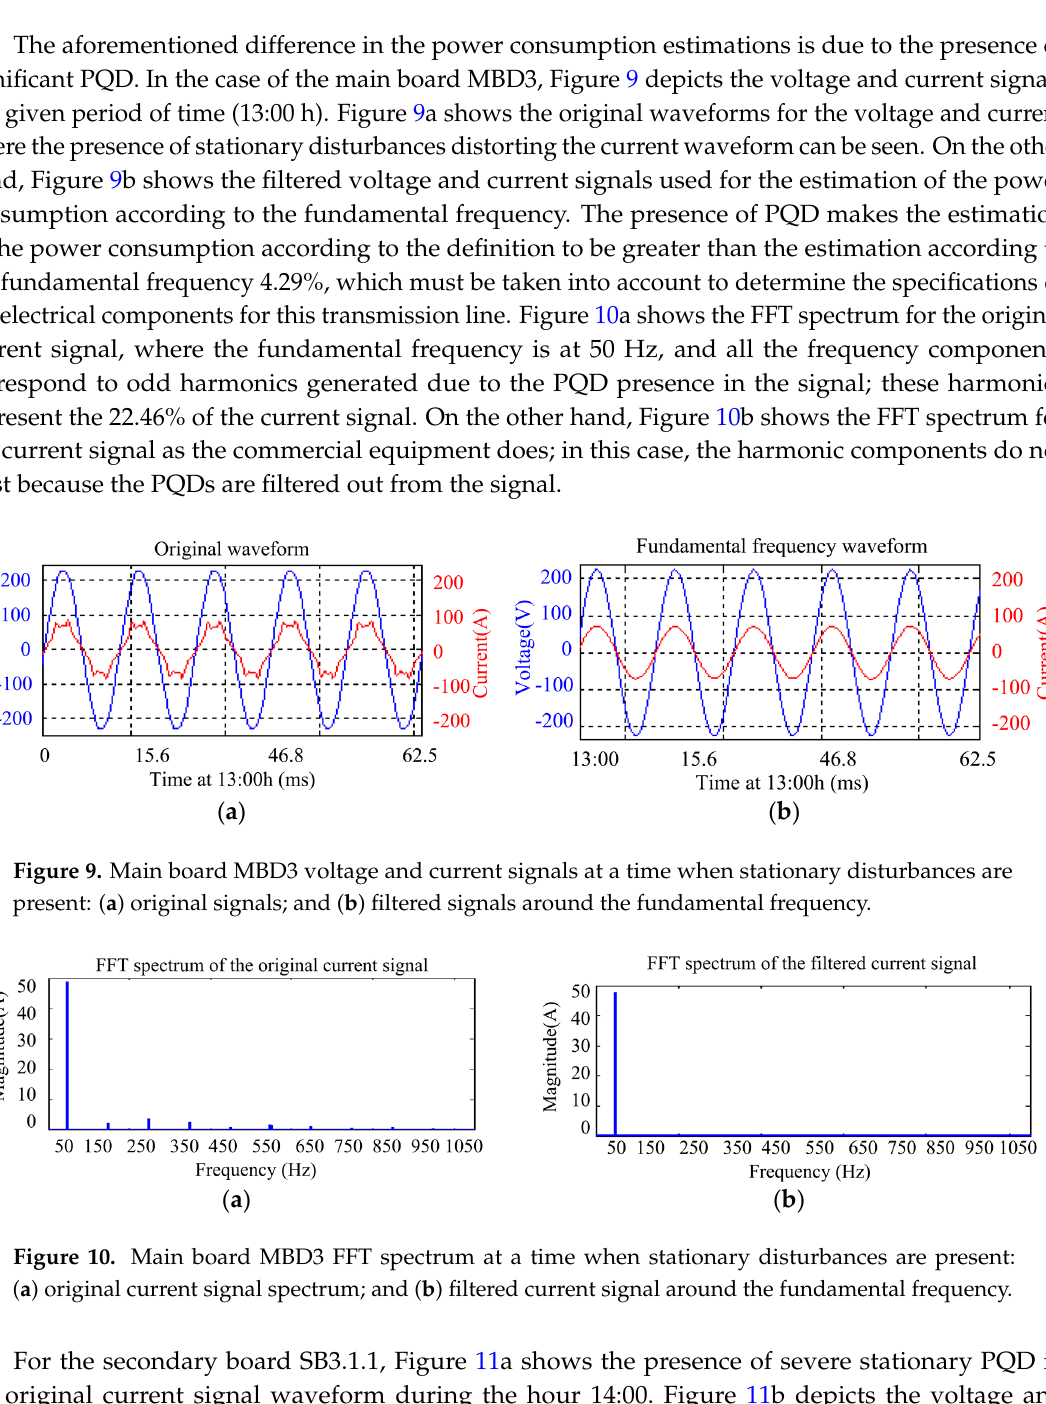
Figure 11. Secondary board SB3.1.1 voltage and current signals at a time when severe stationary disturbances are present: ( a ) original signals; and ( b ) filtered signals around the fundamental frequency.